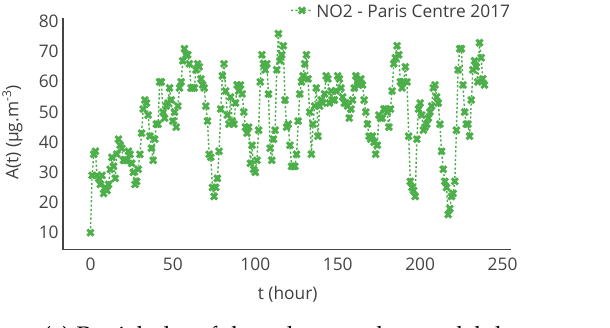
Figure 3. Examples of maps of concentration C used following C ( x , y ) = A exp for given A and FWHM .